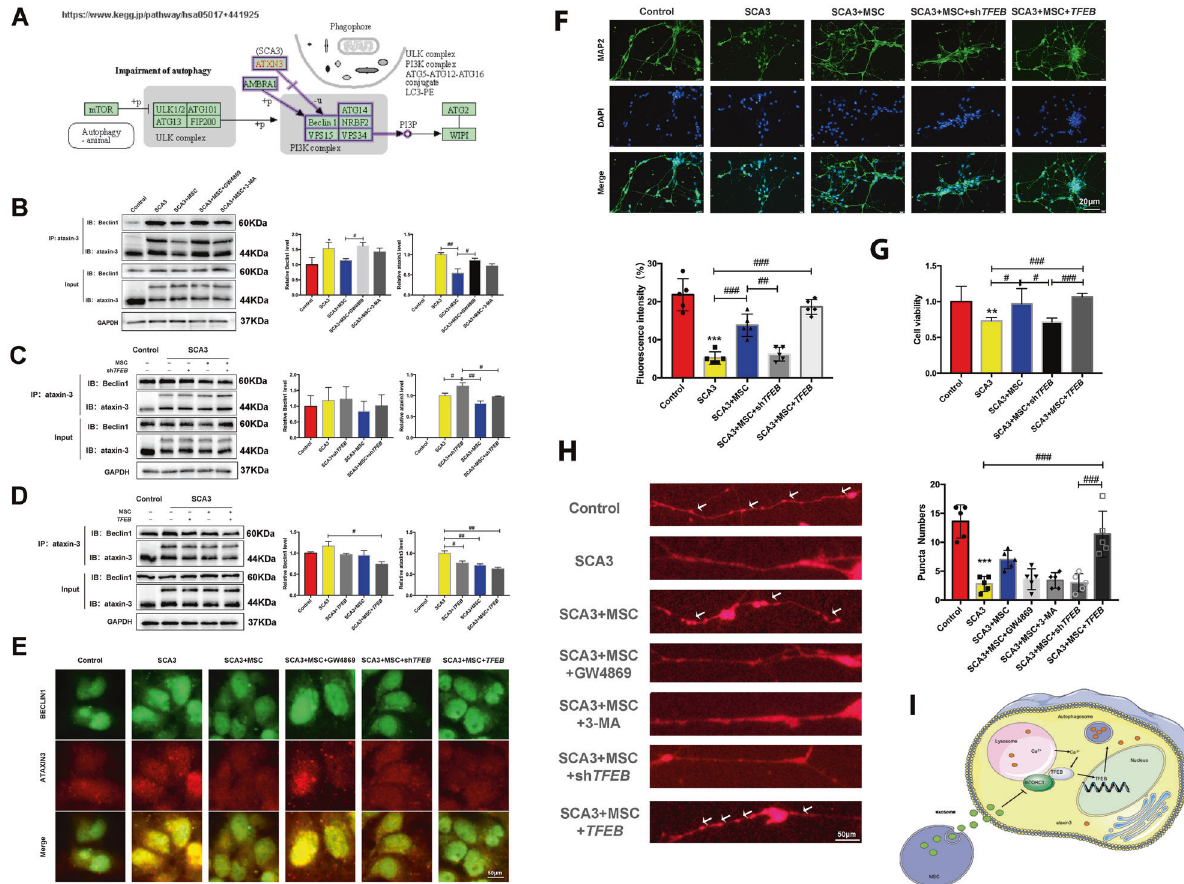
Fig. 6 TFEB-dependent MSCs therapy attenuated Beclin1 ubiquitination of ataxin-3 protein and the toxic effects of mutant proteins in SCA3 neurons. A A diagram that comes from www.kegg.jp/pathway. B The effects of GW4869 and 3-MA on the interaction of Beclin1 and ataxin-3 using Co-IP. C The effects of shTFEB on the interaction of Beclin1 and ataxin-3 through Co-IP. D The effects of TFEB on the interaction of Beclin1 and ataxin-3 by Co-IP. E The effects of shTFEB and TFEB on the interaction of Beclin1 and ataxin-3 by immuno fl uorescence (scale bar: 50 μ m). F The effects of shTFEB and TFEB on the neuron-speci fi c marker MAP2 after MSCs by immuno fl uorescence (scale bar: 20 μ m). G The effects of shTFEB and TFEB on neuron survival and proliferation. H The effects of shTFEB , TFEB , 3-MA, and GW4869 on the synaptic protein PSD95 after MSCs (scale bar: 50 μ m). I Schematic diagram of the proposed mechanism. * p < 0.05, ** p < 0.01, *** p < 0.001 vs Control group, # p < 0.05, ## p < 0.01, ### p < 0.001. The balance between ubiquitin-proteasome and autophagy is essential for maintaining a balance between cell quality control and protein homeostasis. The ataxin-3 protein binds to the ubiquitinated protein through the UIM domain and acts as a ubiquitin hydrolase. So, ataxin-3 is a key factor binding in the ubiquitin-proteasome and autophagy pathway [1]. It has been reported that the wild-type ataxin-3 can interact with the autophagy protein, Beclin1, and that the deubiquitination activity